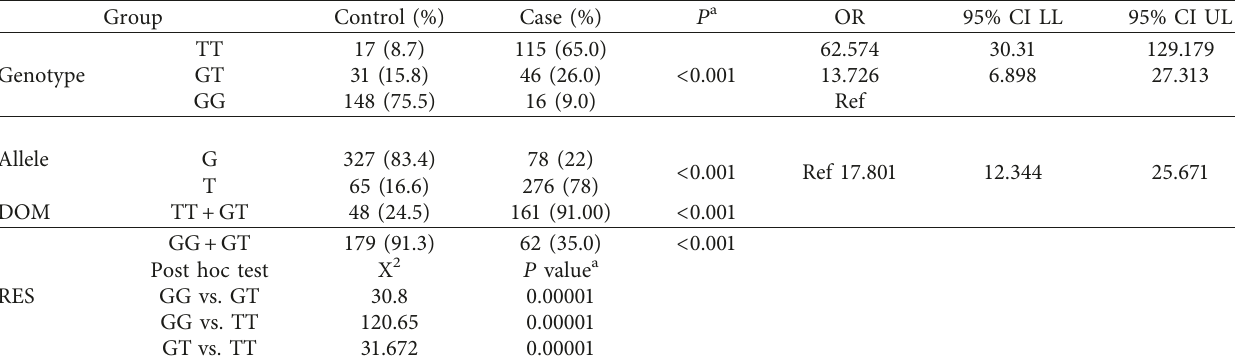
Table 2: Genotype and allele frequencies of ET-1 rs5370 polymorphism.